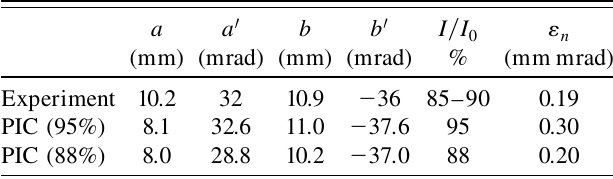
Comparison of experimentally observed beam envelope, centroid, current (from Faraday cup data), and emit- tance at d 5 to the PIC simulation.